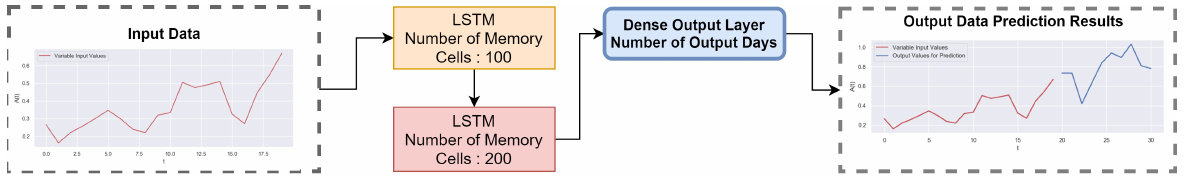
Figure 7. LSTM Model for Daily Coronavirus Cases